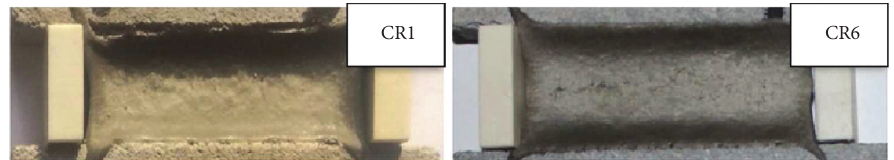
Figure 6: Typical constant elongation failure modes of groups of